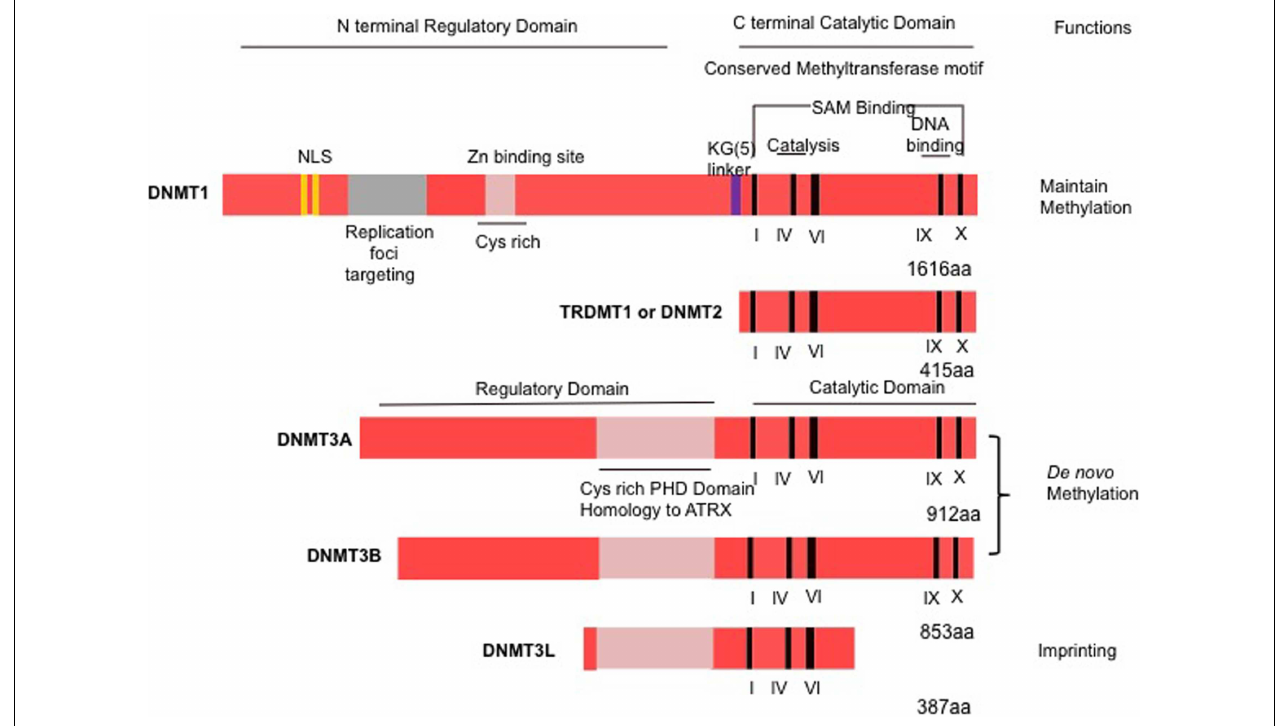
FIGURE 1 | Schematic representation of the human DNMT1, DNMT2, orTRDMT1 and DNMT3A, 3B, and 3L. The N-terminal contains motifs of interaction with proteins or DNA.The C-terminal contains the conserved methyltransferases domains. PHD, plant homology domain.